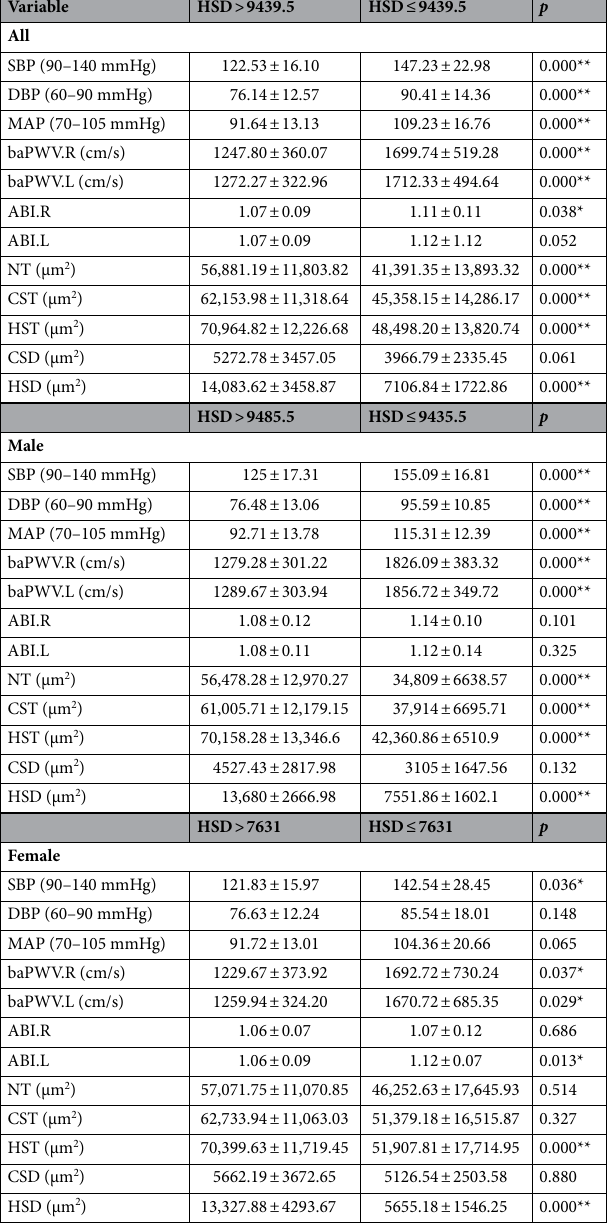
Table 8. Descriptive analysis between blood pressure, arterial stiffness, and microvessel